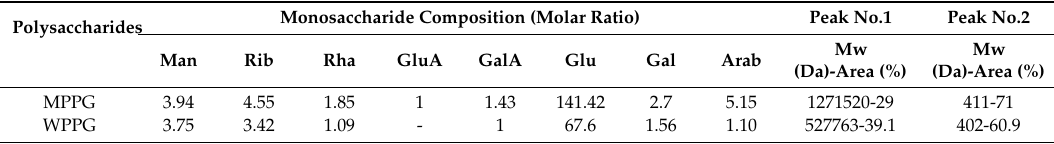
Table 4. Physicochemical properties of purified polysaccharides.